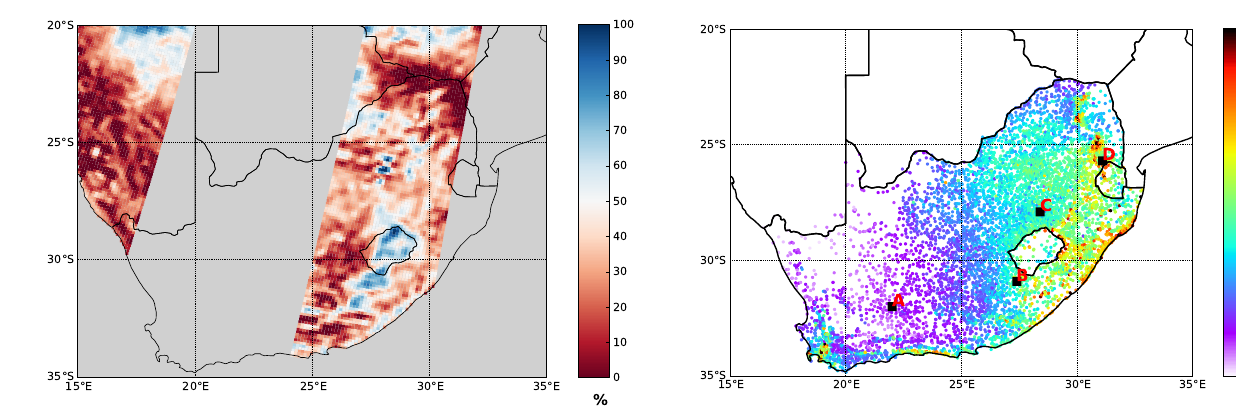
Fig. 10. Relative surface soil moisture (SSM) retrieval from AS- CAT. The satellite overpass time is approximately eight hours after the TOPKAPI SSI estimates shown in Fig. 9.